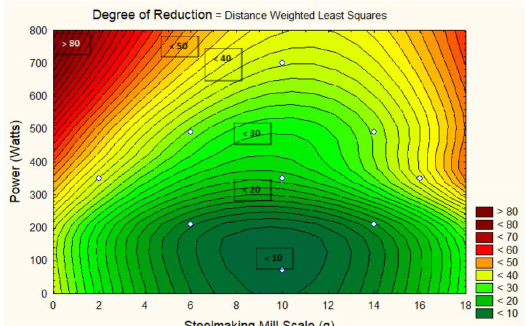
Figure 7. Contour plot of the degree of reduction as a function of the steelmaking mill scale mass variation and the time of contact of the mixture with microwave